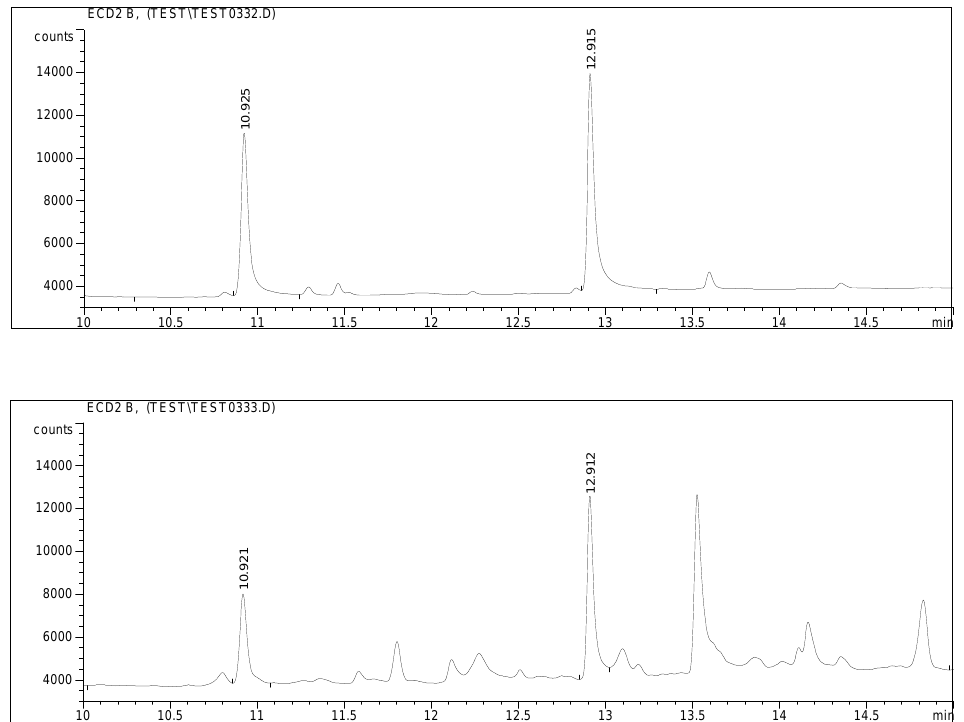
Figure 2 . GC-ECD chromatogram of 0.5 µ g/ml OA standard (top); OA spiked at a concentration of 0.5 µ g/g tissue